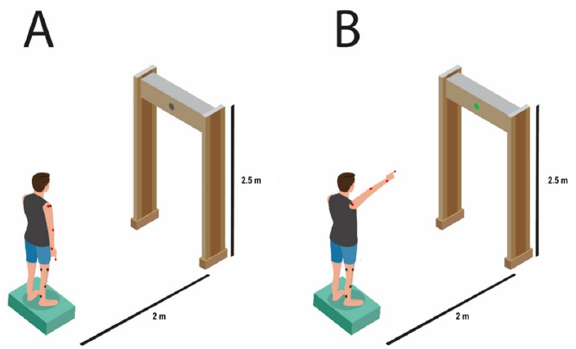
Figure 1. Demonstration of the experimental setup for the task. Figure ( A ) illustrates a participant in the initial position of the task, in a side view, with arms by the side of the body, and looking at the LED, which is off; Figure ( B ) represents the final position of the task, in which the individual stands with their arm raised and index finger pointing to the LED, which is on. LED: light emitting